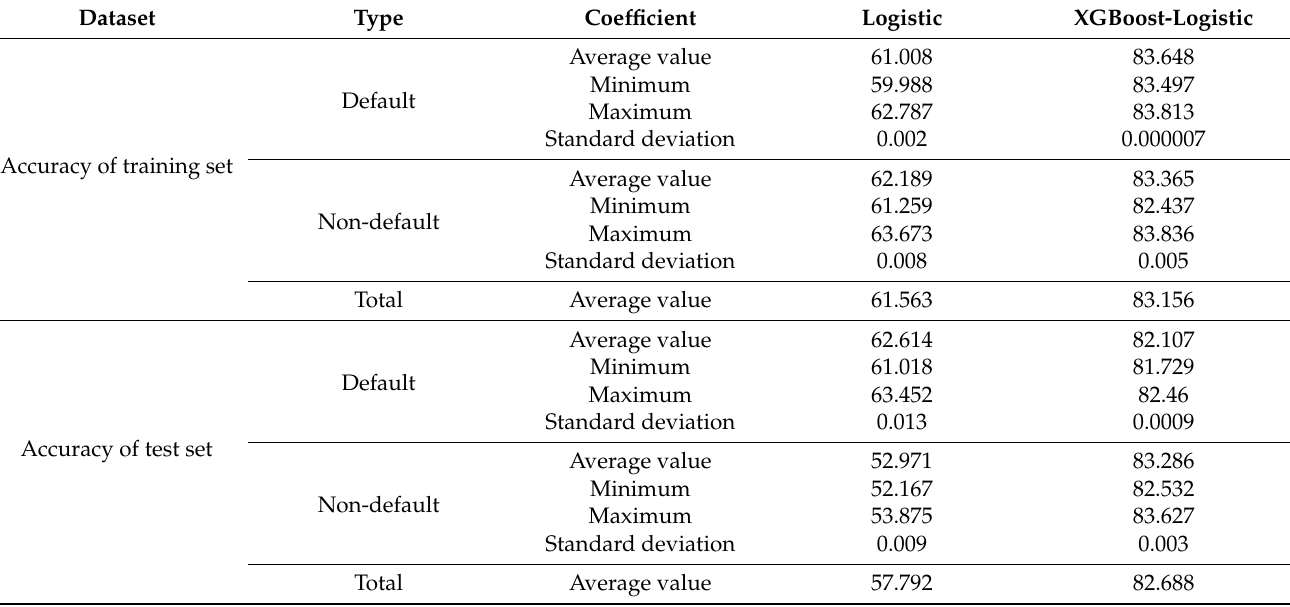
Table 7. Datasets comparison and model